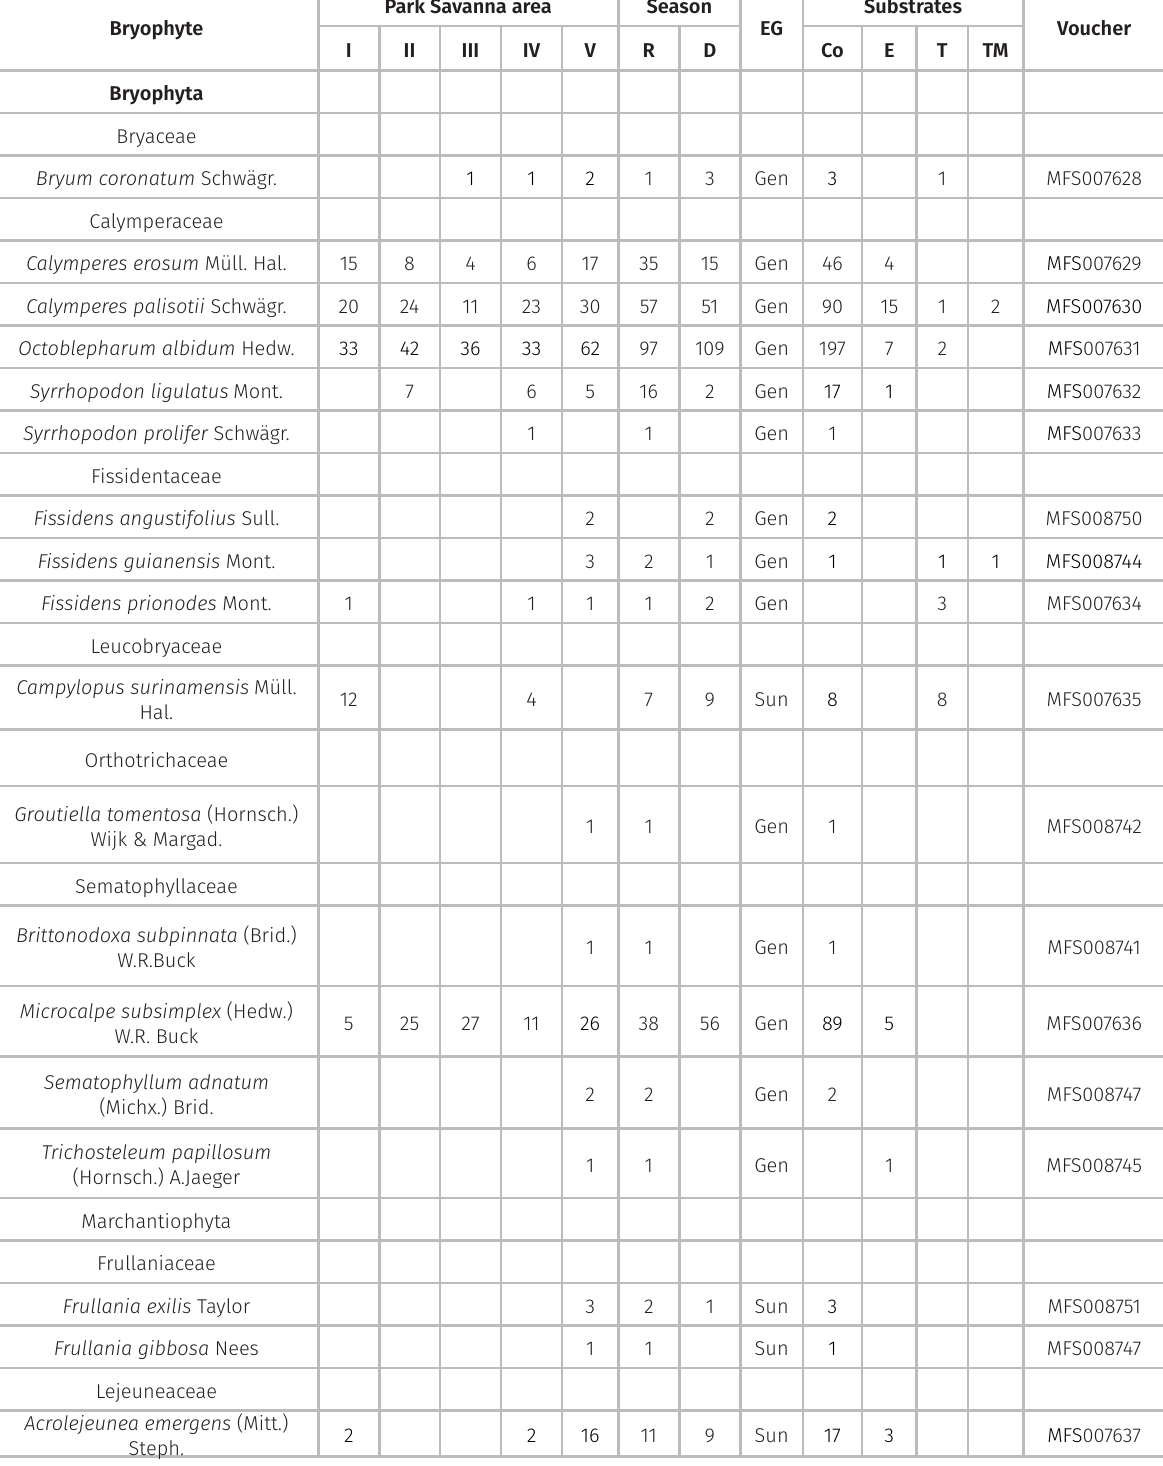
Table II. List of bryophytes of the five Park Savanna areas in Marajó Island, Pará. Park Savanna area Season Bryophyte I II III Co E T